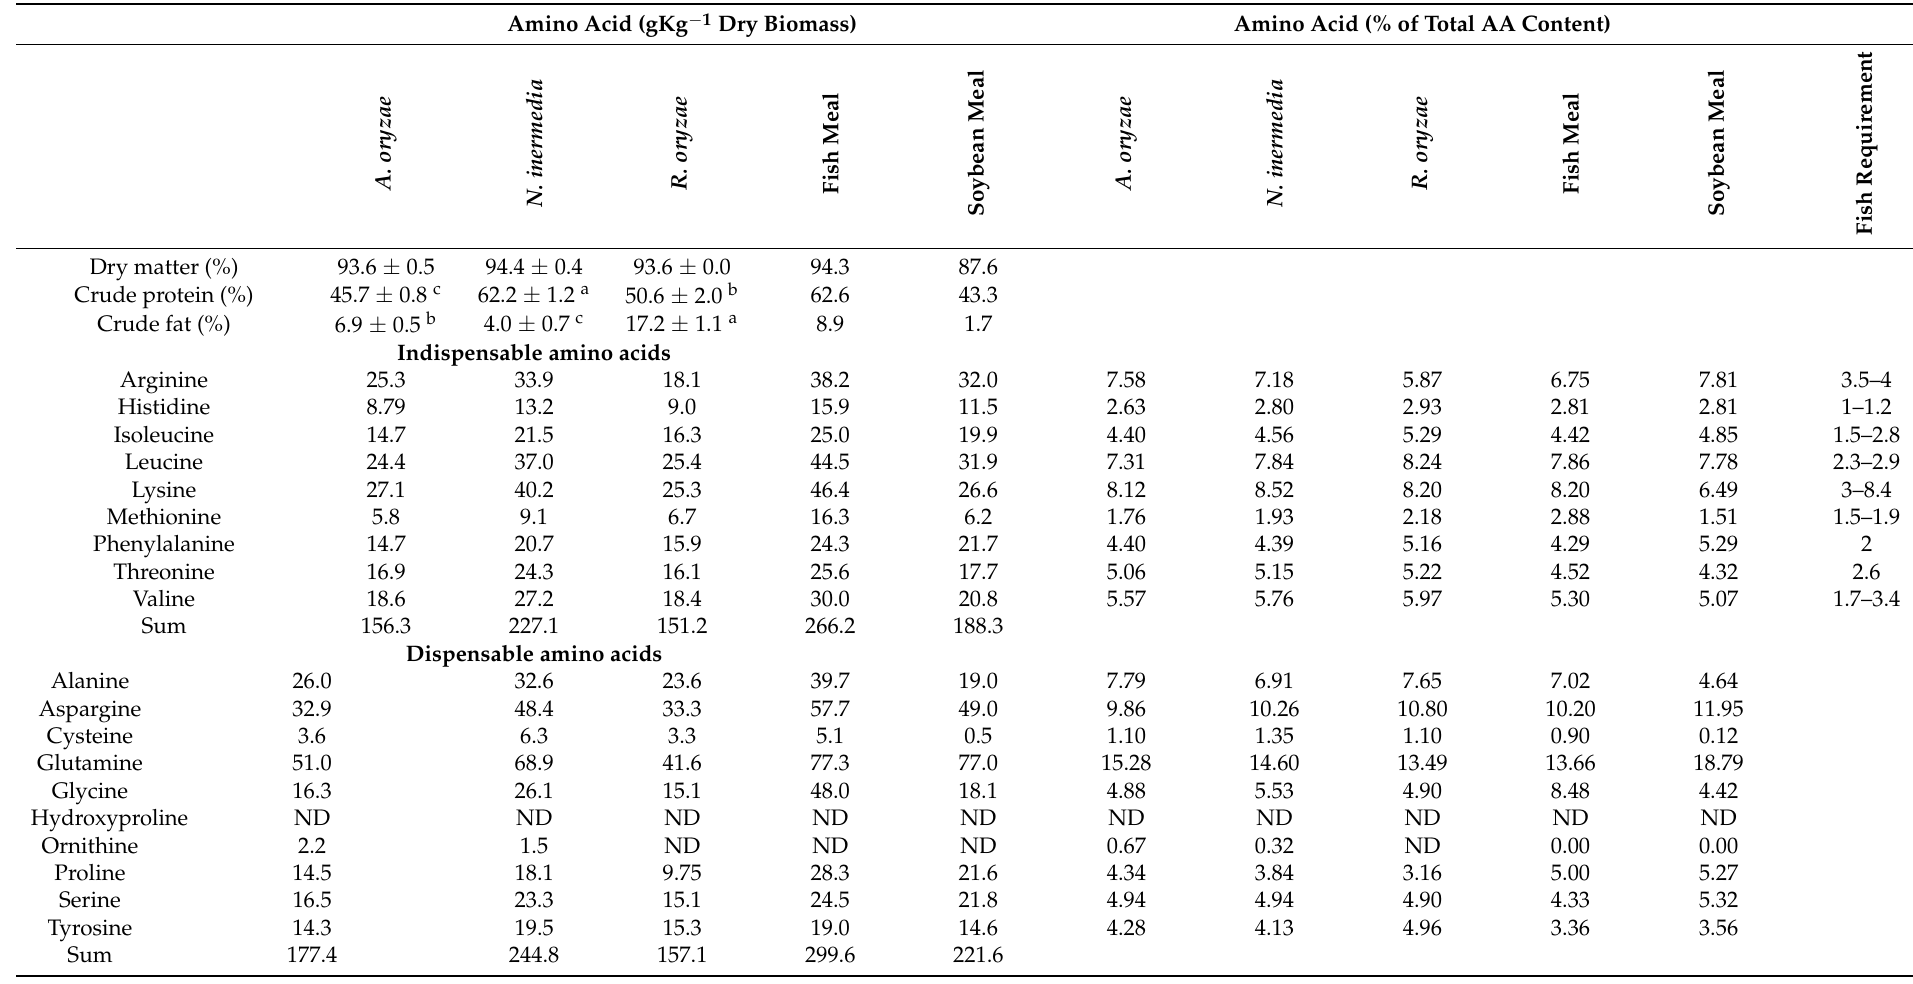
Table 1. Proximate composition and amino acid profile of A. oryzae , N. intermedia and R. oryzae , fish meal and soybean. Fish meal and Soybean